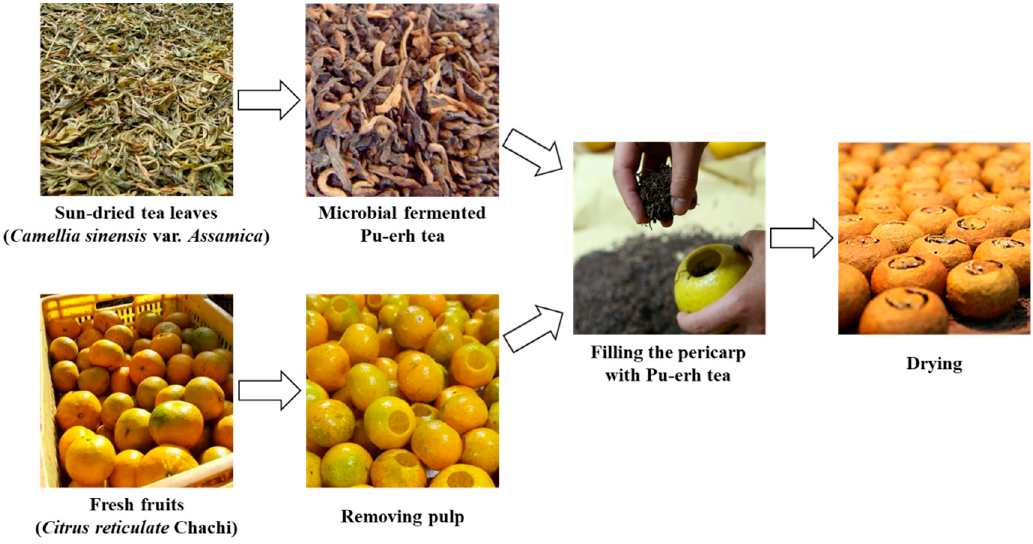
Figure 1. Manufacturing process of Ganpu tea.